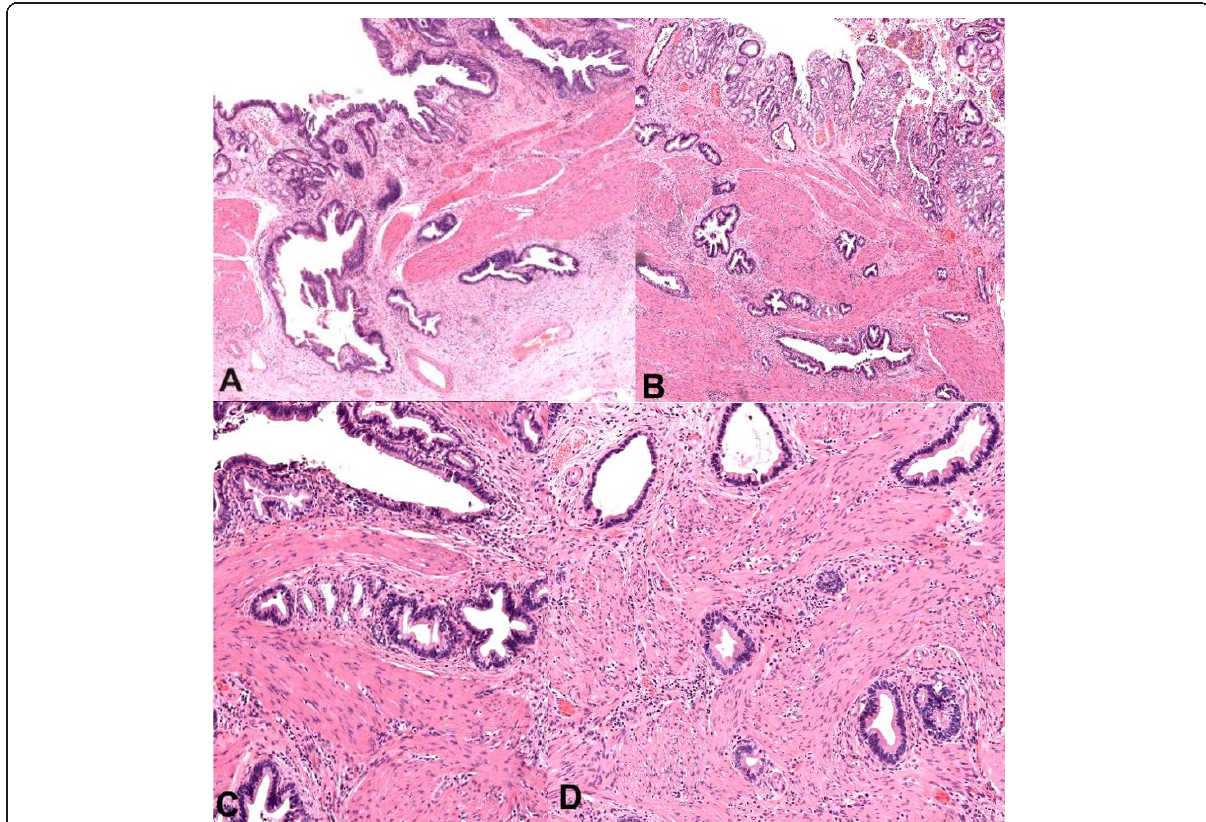
Figure 2 Dysplasia in RAS and adenomyosis can mimic invasive GBC . A-B: Dysplastic epithelium within RAS penetrating slightly beyond the wall, C: dysplastic epithelium associated with adenomyosis, D: Foci of intramural invasive carcinoma (H&E